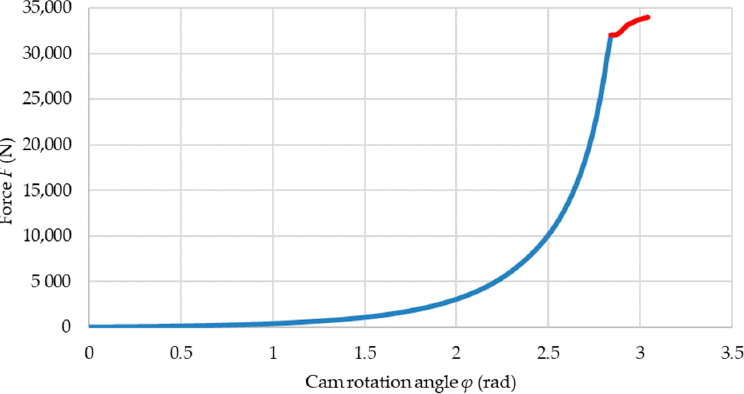
Figure 16. Characteristic curve for the variance of the compaction force F obtained from experimental studies as a function of the rotation angle of cam 7 (Figure 13).